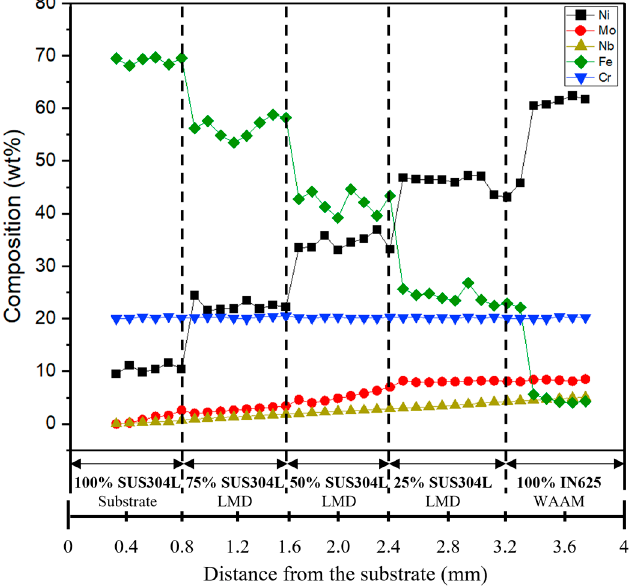
Figure 7. EDS line scanning curves of major element composition along the deposition direction.